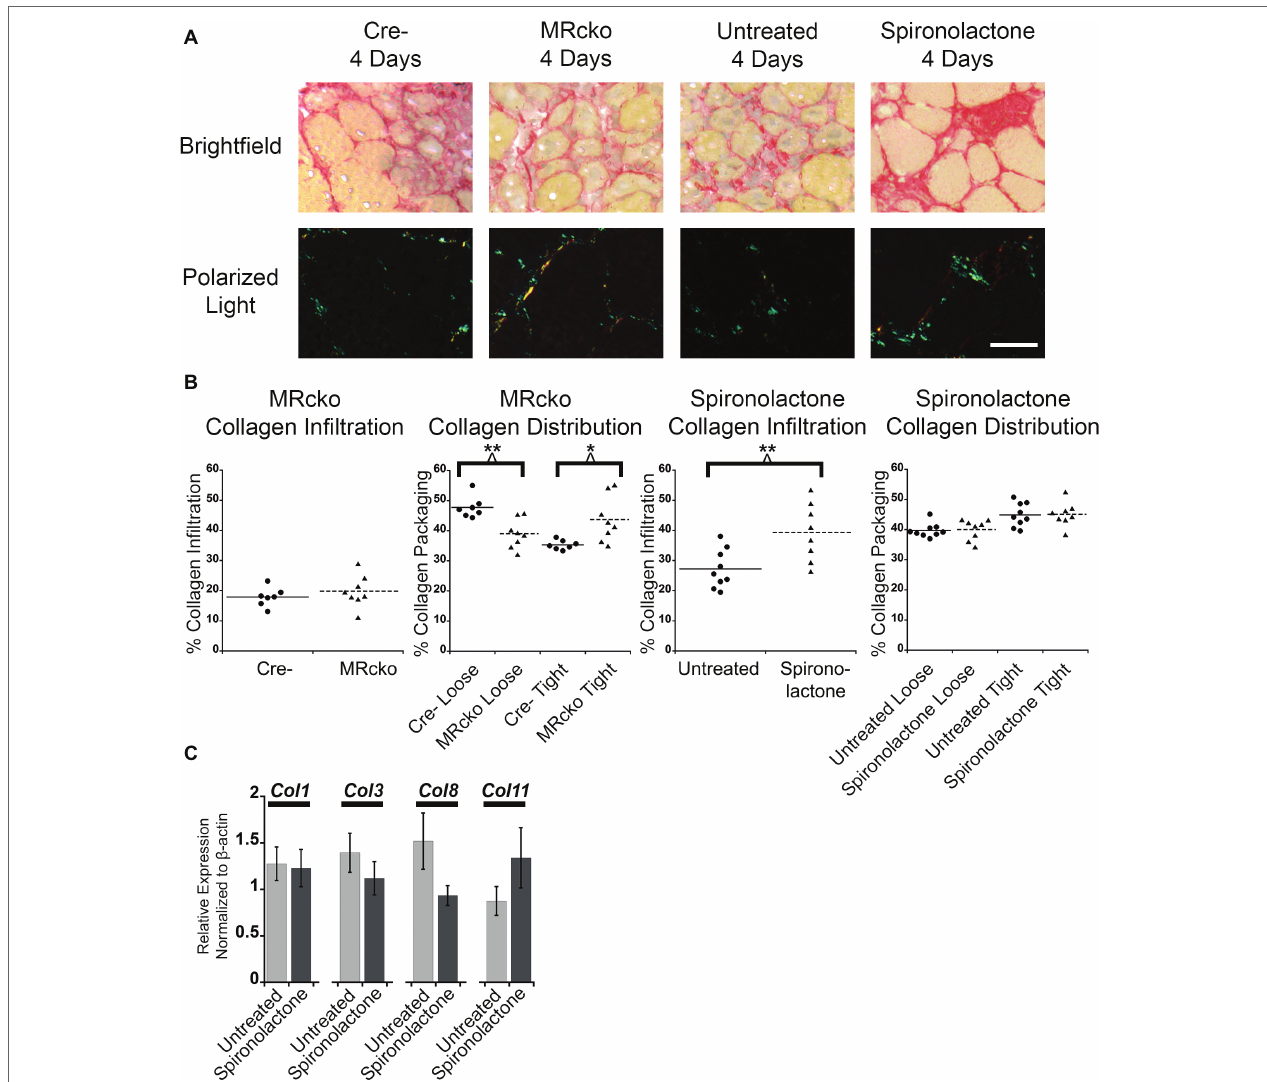
FIGURE 6 | MRcko and MR antagonist treatment results in increased detrimental collagen infiltration. (A) Representative images of tibialis anterior muscle after picrosirius red staining under brightfield to quantify total collagen and polarized light to quantify collagen packaging. Loosely packaged collagen appears green and tightly packaged collagen appears red under polarized light. Scale bar = 40 μ m (B) Dot plots of percent muscle area containing collagen infiltration and percent of loosely and tightly packaged collagen at 4 days after acute muscle injury for MRcko mice ( n = 7 Cre − , and 8 MRcko) and spironolactone-treated mice ( n = 8 untreated, 8 spironolactone) Means are shown by lines for each group in the dot plots. (C) Bar graph showing four representative collagen genes involved in fibrosis assessed in spironolactone treated ( n = 5) and untreated ( n = 5) littermates. Beta-actin levels were used as a normalization control. Col1 , collagen 1 alpha 1; Col3 , collagen 3 alpha 1; Col8 , collagen 8 alpha 1; Col11 , collagen 11, alpha 1. Data are presented as mean ± SEM. All data were analyzed using a Student’s t -test, * p ≤ 0.05 and ** p ≤